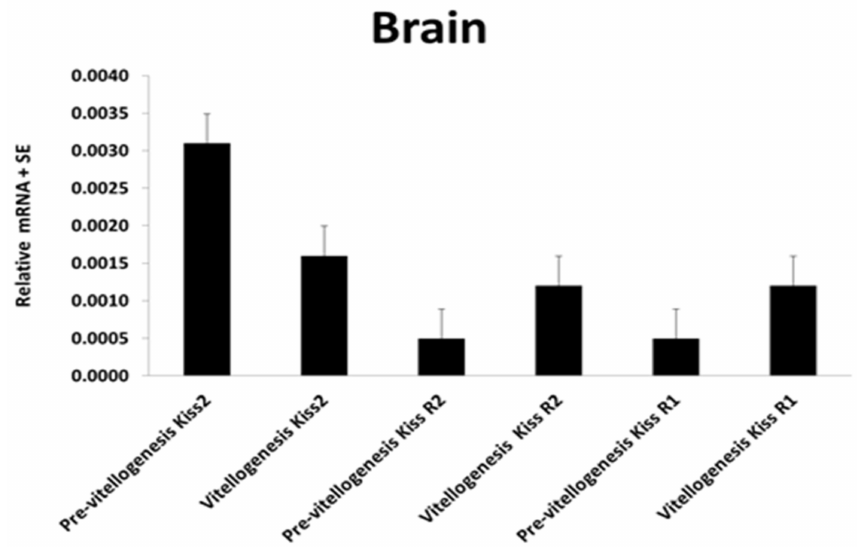
Figure 5. Comparing the gene transcriptions of Kiss2, KissR1, and KissR2 in the brain of female blue gourami during oogenesis